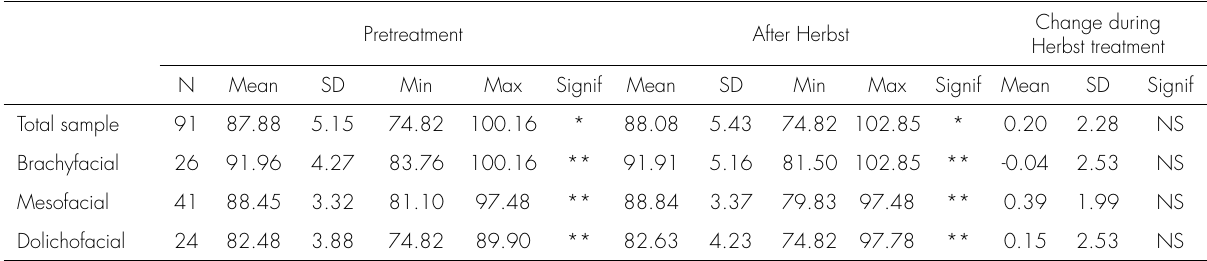
Table X. Facial axis angle (degrees).